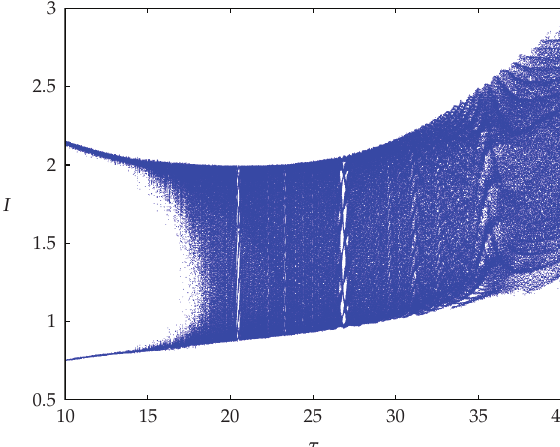
Figure 7: Bifurcation diagram of system (cid:2) 1.1 (cid:3) : successive maxima of the infected are plotted for increasing time delay τ , with parameters r (cid:8) 0 . 1, K (cid:8) 80, β (cid:8) 0 . 1, μ 1 (cid:8) 0 . 5, μ 2 (cid:8) 0 . 1, α (cid:8) 0 . 05m , and γ (cid:8) 0 . 75.